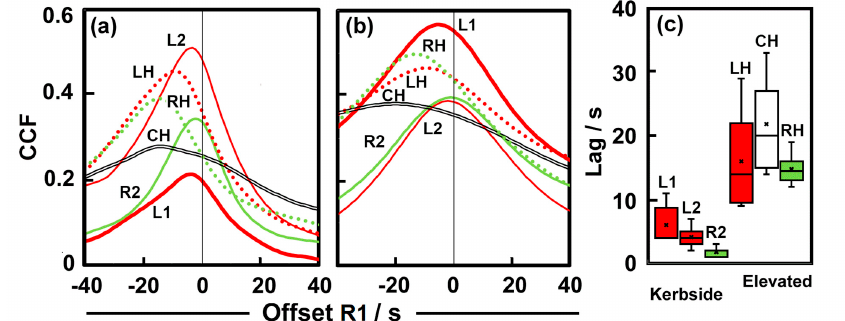
Figure 5. ( a ) The cross-correlation function (CCF) of 1-s NOx concentrations from the other six nodes with R1 on 12–28 and ( b ) CO. ( c ) The lag of each node for both NOx and CO with node R1 determined for the four